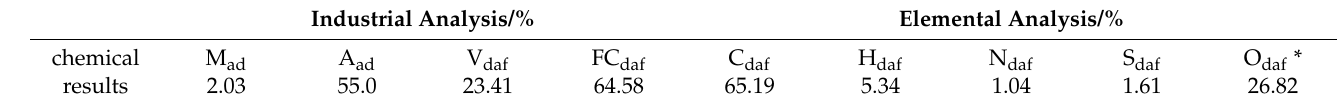
Table 1. Proximate and elemental analyses of coal slime (ultrafine coal).